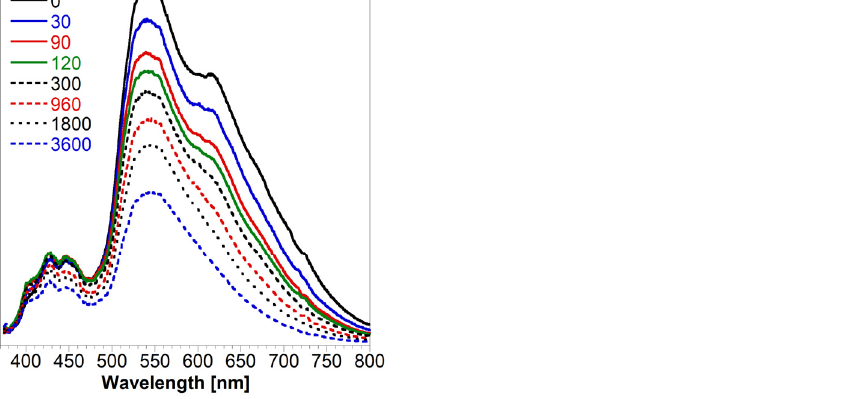
Figure 3. PL emission spectra of the DCA-DPH:DBT:DBTT films without any additives with different times of UV light irradiation (from 0 to 3600 s).